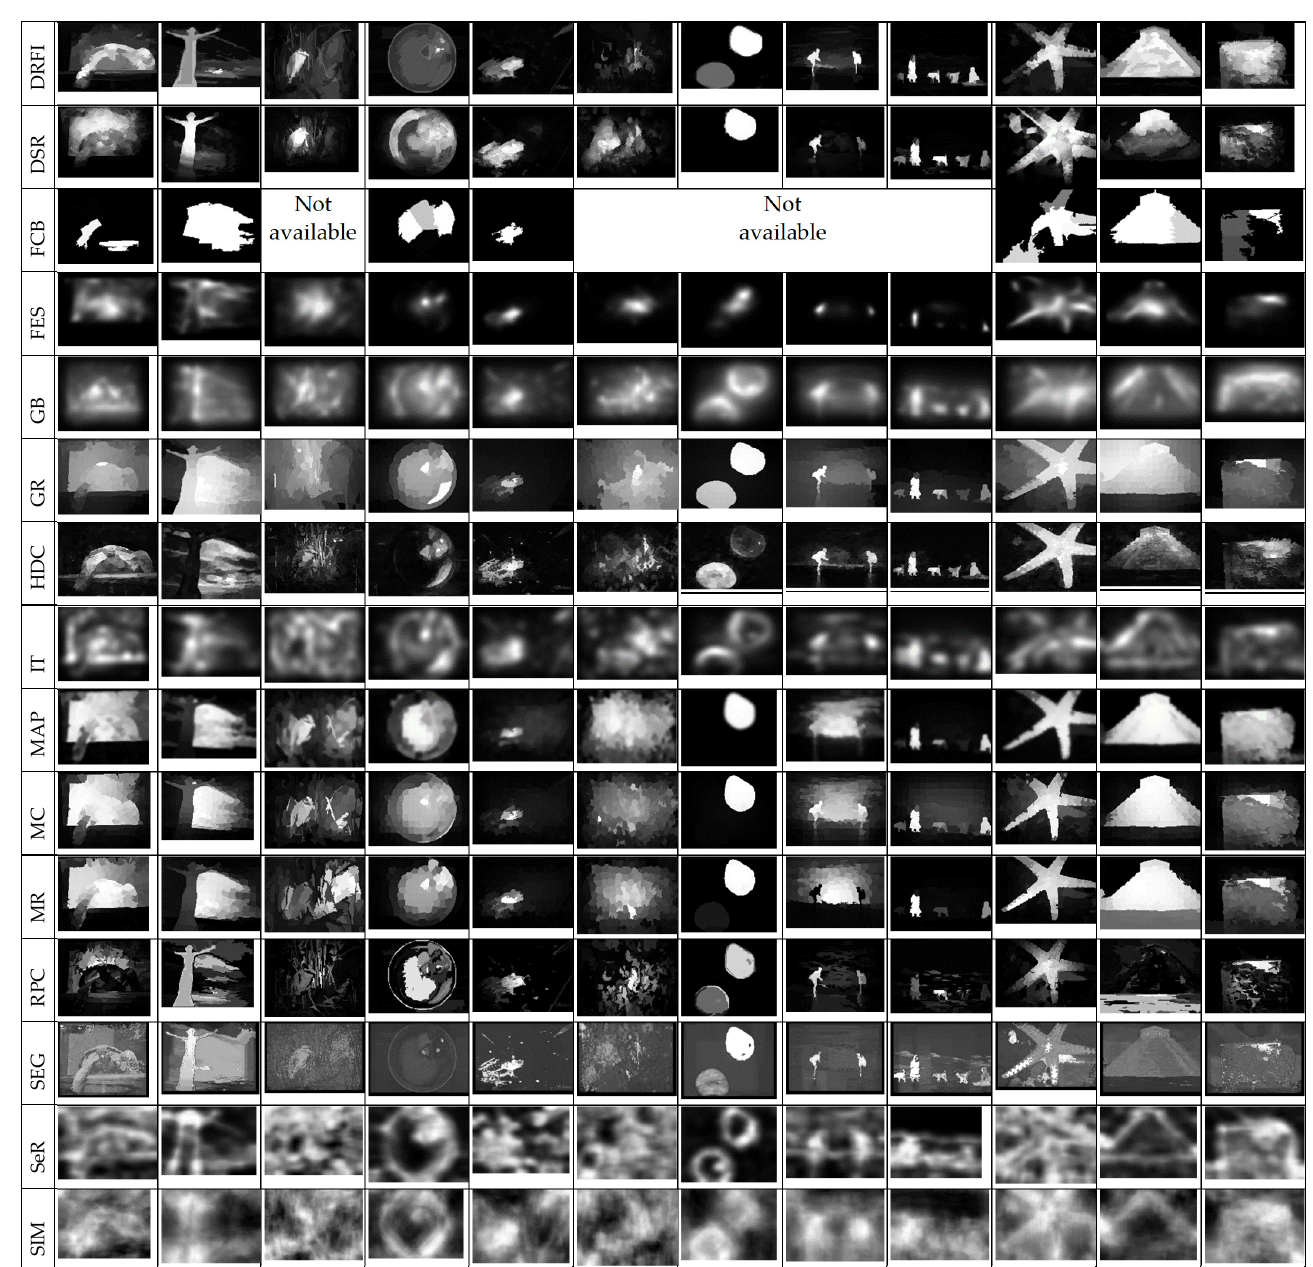
Figure 3. Qualitative performance of the investigated methods on ECSSD and selected categories of images: ( a ) ECSSD; ( b ) Boundary; ( c ) Center; ( d ) Complex Background; ( e ) Low Contrast; ( f ) Multiple Objects; ( g ) Overlap.